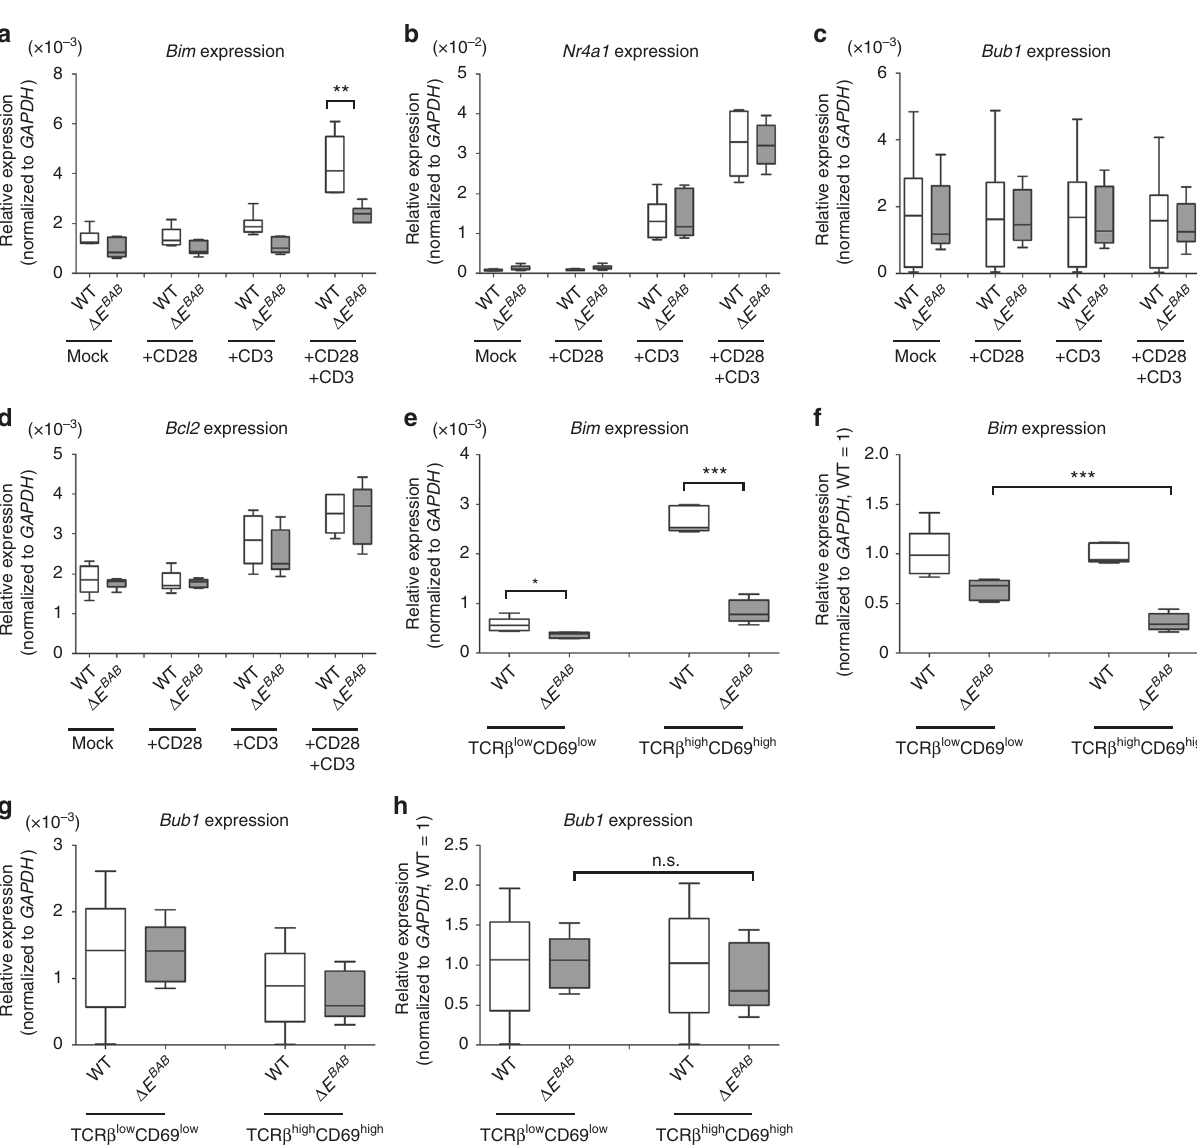
Fig. 5 E BAB regulates Bim expression upon TCR stimulation. a – d Gene expression changes for Bim ( a ), Nr4a1 ( b ), Bub1 ( c ), and Bcl2 ( d ) in total thymocytes stimulated for 3 h with anti-CD3 and anti-CD28 antibodies (10 µ g/ml). e , f Gene expression level ( e ) and relative gene expression to WT ( f ) for Bim in pre- selection (TCR β low CD69 low ) and post-selection (TCR β high CD69 high ) thymocytes. g , h Gene expression level ( g ) and relative gene expression to WT ( h ) for Bub1 in pre-selection (TCR β low CD69 low ) and post-selection (TCR β high CD69 high ) thymocytes. Data are pooled from six independent experiments ( a – d ; n = 6 sex-matched WT – Δ E BAB pairs, 9 – 18 weeks old) or fi ve independent experiments ( e – h ; n = 5 sex-matched WT – Δ E BAB pairs, 10 – 18 weeks old). Edges of the box are the 25th and 75th percentiles, and error bars extend to the maximum and minimum. Outliers are de fi ned as the data point that is located outside of q 3 + 1.5( q 3 − q 1 ) and q 1 − 1.5( q3 − q 1 ), in which q 1 and q 3 are the 25th and 75th percentiles. n.s. not signi fi cant ( P ≥ 0.05); * P < 0.05, ** P < 0.01, *** P < 0.001 (unpaired two-tailed Student ’ s t